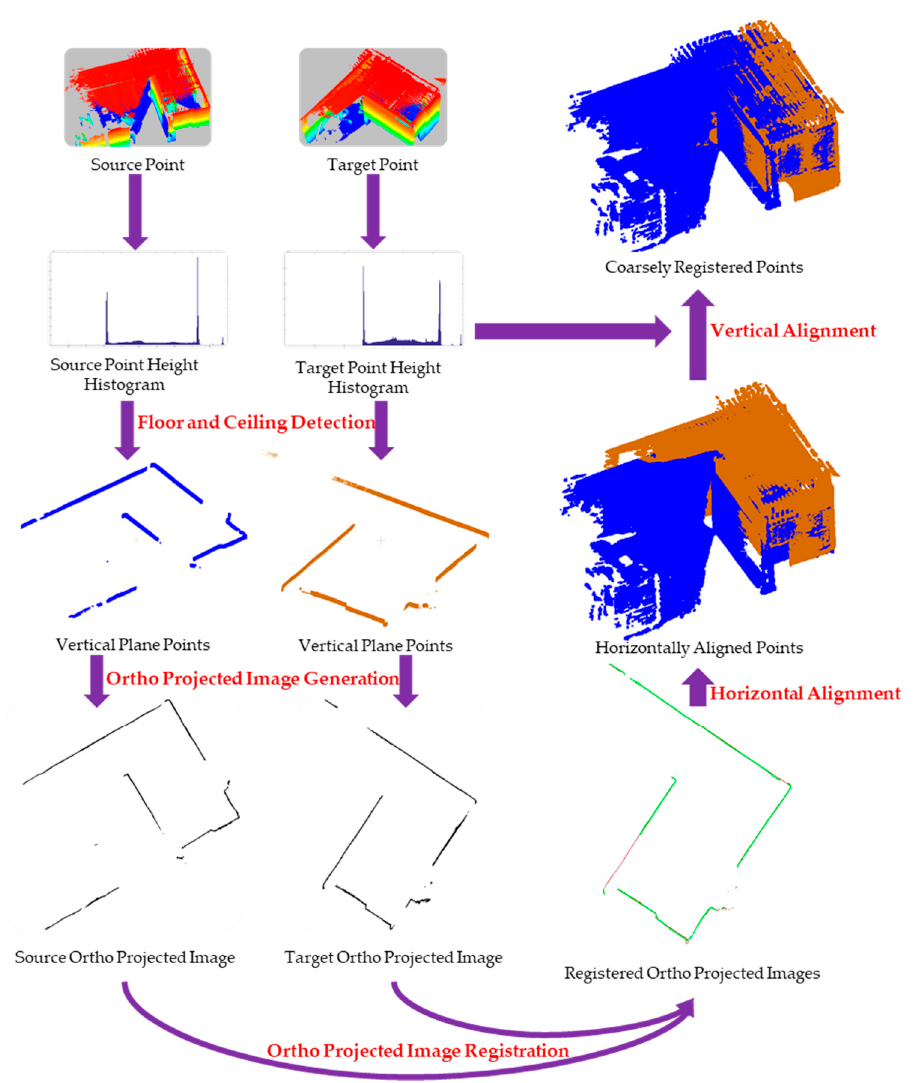
Figure 2. Overview of the proposed 4 degrees of freedom (4DOF) indoor point cloud registration method.